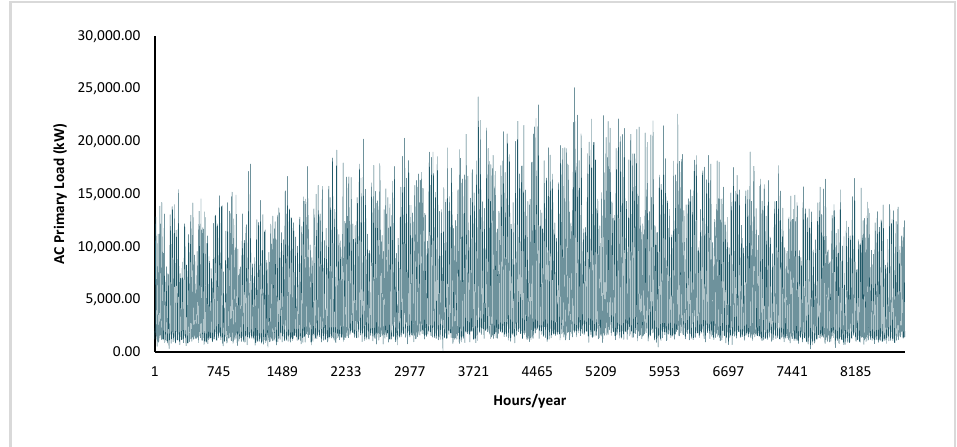
Figure 4. Monthly Average AC Load.